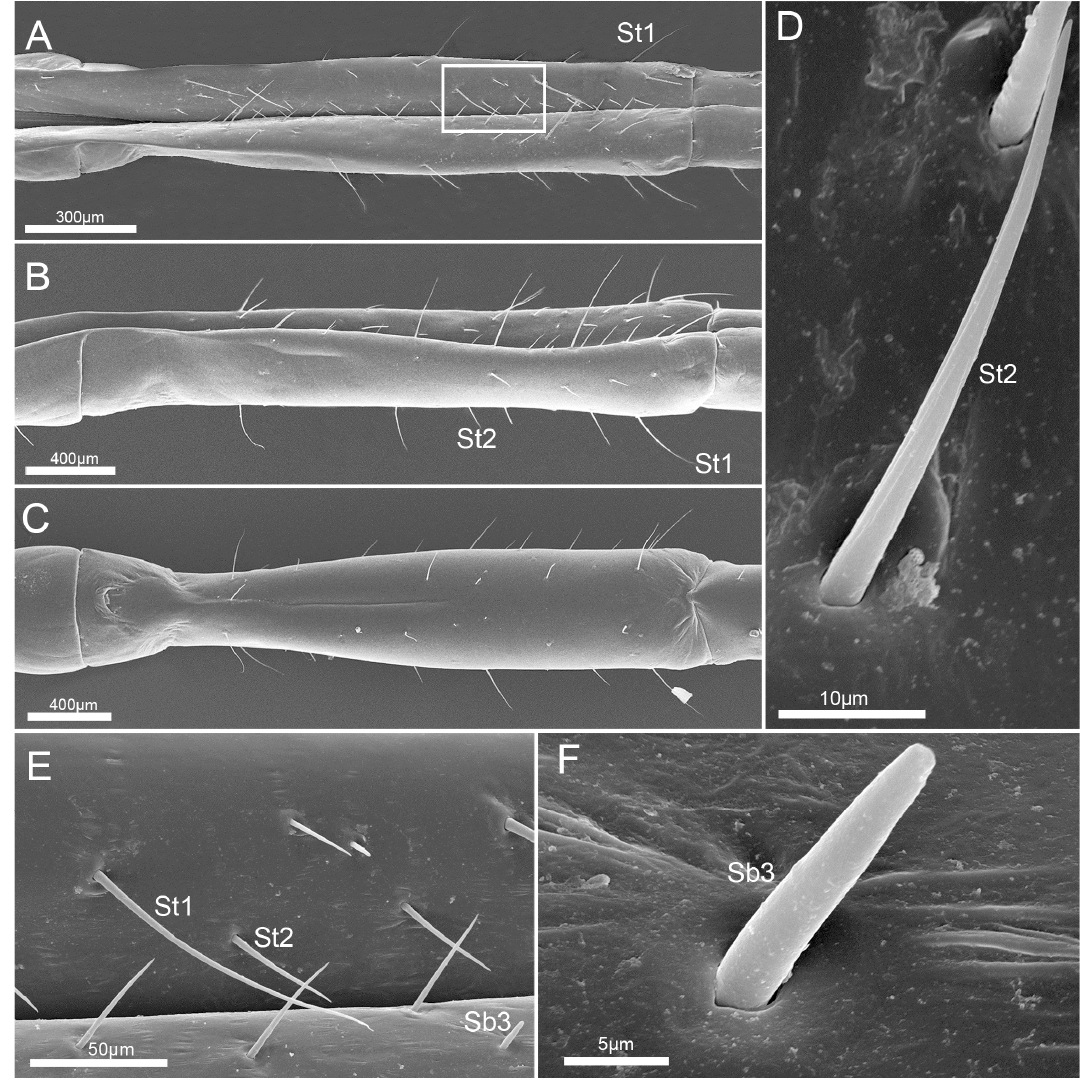
Figure 5. SEM images of the third labial segment. ( A ) Dorsal view; ( B ) lateral view; ( C ) ventral view; ( D ) enlarged view of sensillum trichodeum II (St 2); ( E ) enlarged view of the box in ( A ), showing sensilla trichodea I (St 1), sensilla trichodea II (St 2), and sensilla basiconica III (Sb3); and ( F ) enlarged view of sensillum basiconicum III (Sb3). St 1, sensilla trichodea I; St 2, sensilla trichodea II; and Sb3, sensilla basiconica III.